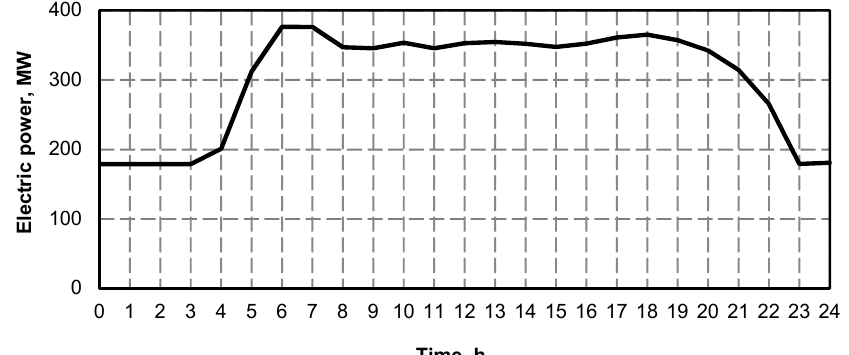
Figure 1. Typical daily power unit curve with a rated power of 370 MW in the Opole power plant taking part in the national power system control.